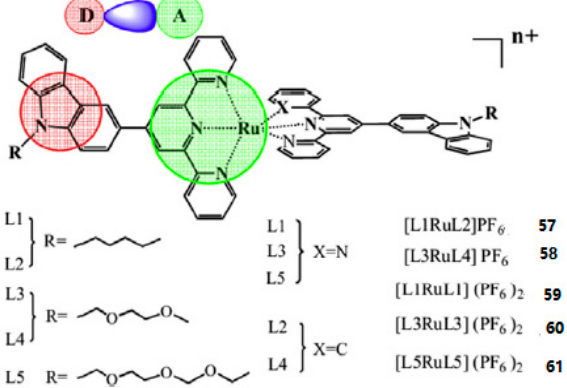
Figure 14. Molecular structures of Ru(II) polypyridyl complexes 57 – 61 . Table 6. Open- and closed-aperture Z-scan measurement data for the third-order nonlinear parameters of 57 – 61 .